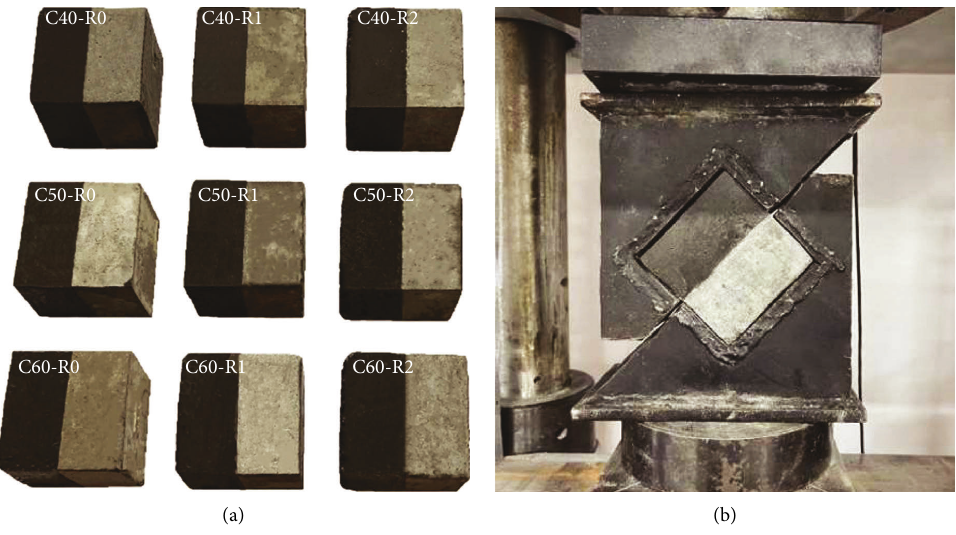
Figure 16: Bond oblique shear specimens and test loading.